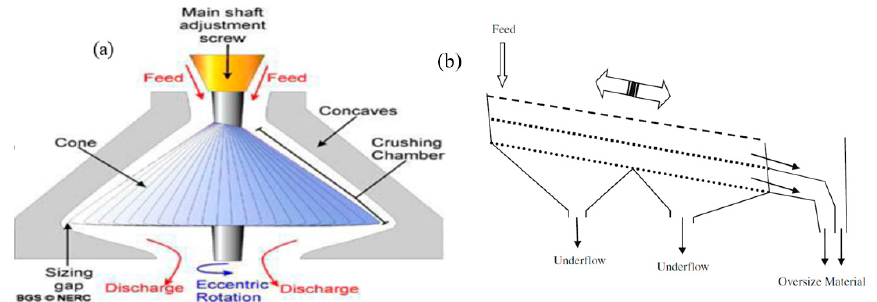
Figure 5. Machines selected for CDW pretreatments: ( a ) cone crusher [70]; ( b ) vibrating screen [71].